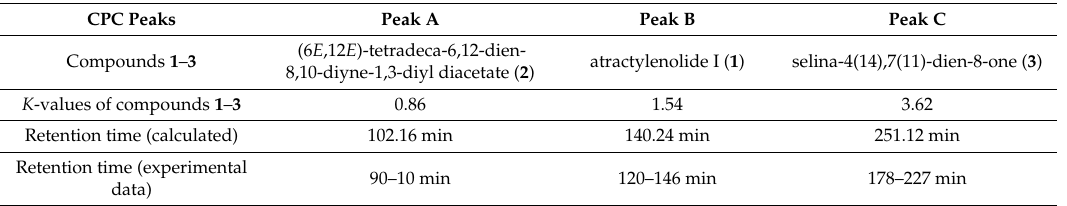
Table 2. Comparison of CPC retention time calculated by K -values and operation result in the two-phase solvent system of n -hexane–ethyl acetate–methanol–water (8:2:8:2, v / v